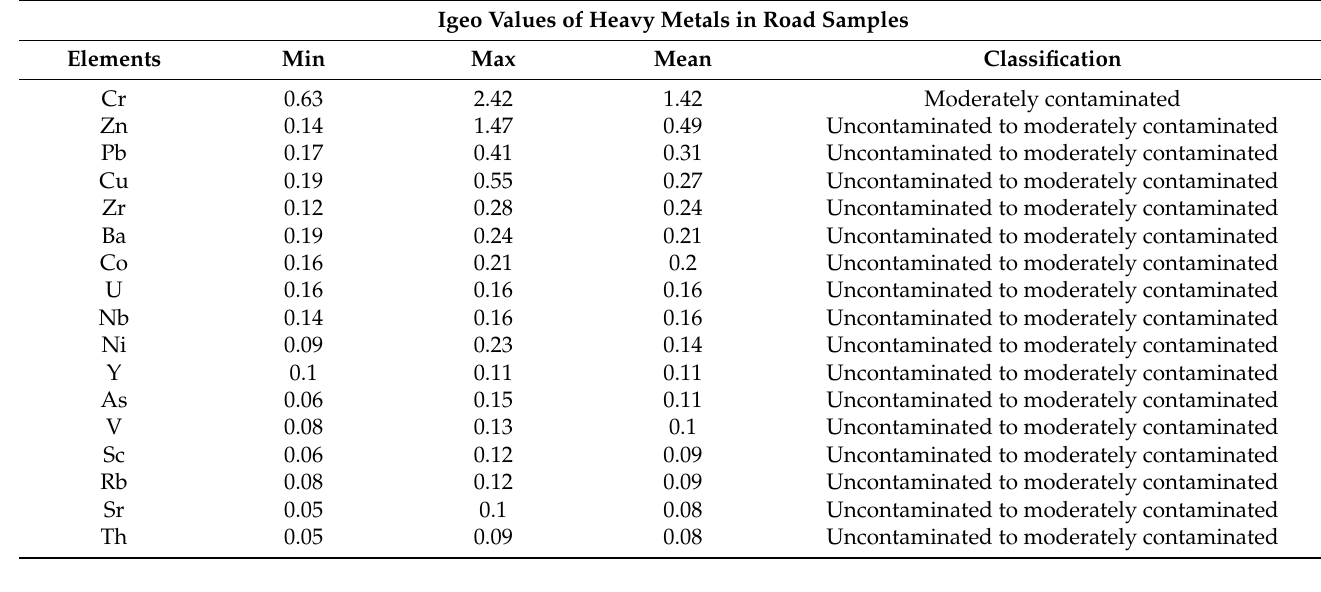
Table 6. Geo-accumulation (Igeo) values of trace element contamination in road dust.